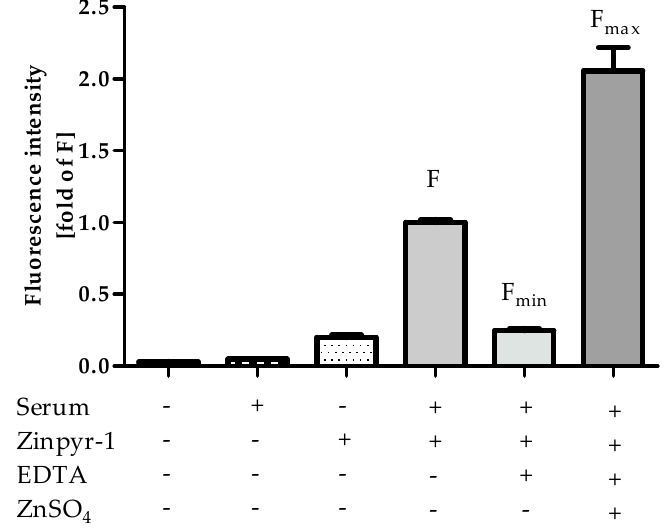
Figure 6. Comparison of fluorescence intensities of controls F, F min and F max . Values were extracted from Figures 2, 3A and 4 are shown relative to F. Data represent means ± SD from n = 3 independent experiments.